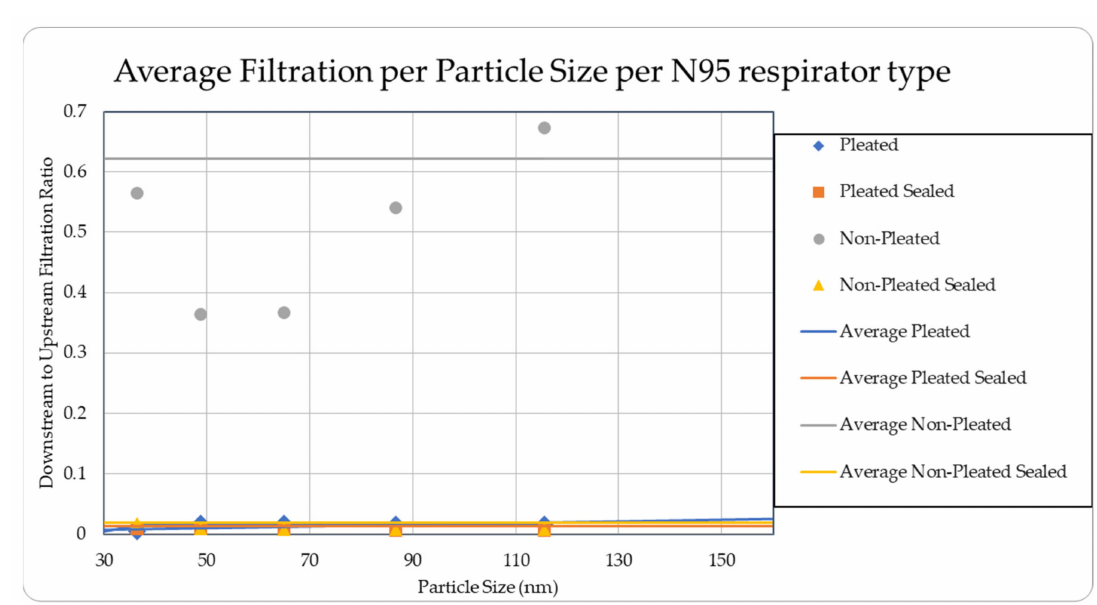
Figure 14. Average filtration ratios per particle size and type at the Asphalt